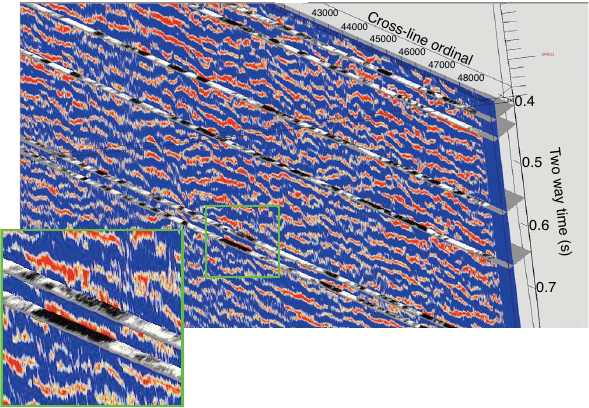
Fig. 10. 3-D view of vertical (color) and horizontal (black and white) slices through the 3-D stack volume. Data is un-migrated and a uniform gain has been applied. Cross-line ordinals denote the grid boxes in the along-swath direction. Green box outlines zoomed-in region shown in the